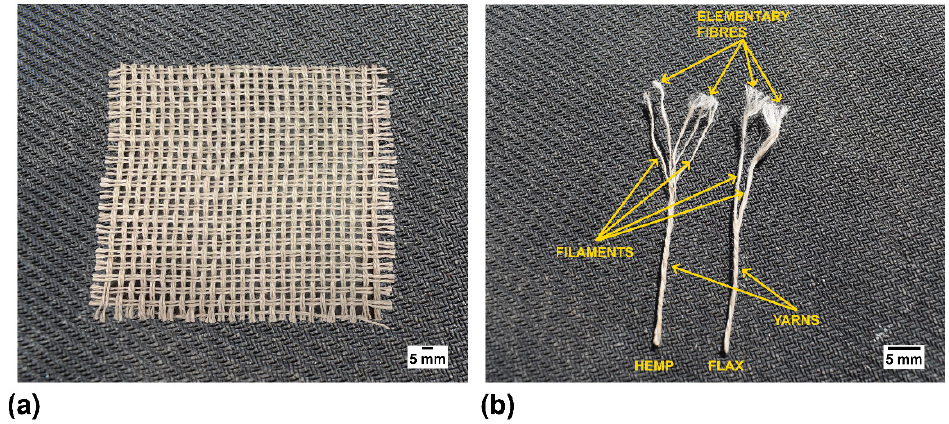
Figure 1. ( a ) Fabric adopted as reinforcement and ( b ) magnification of hemp and flax yarn.